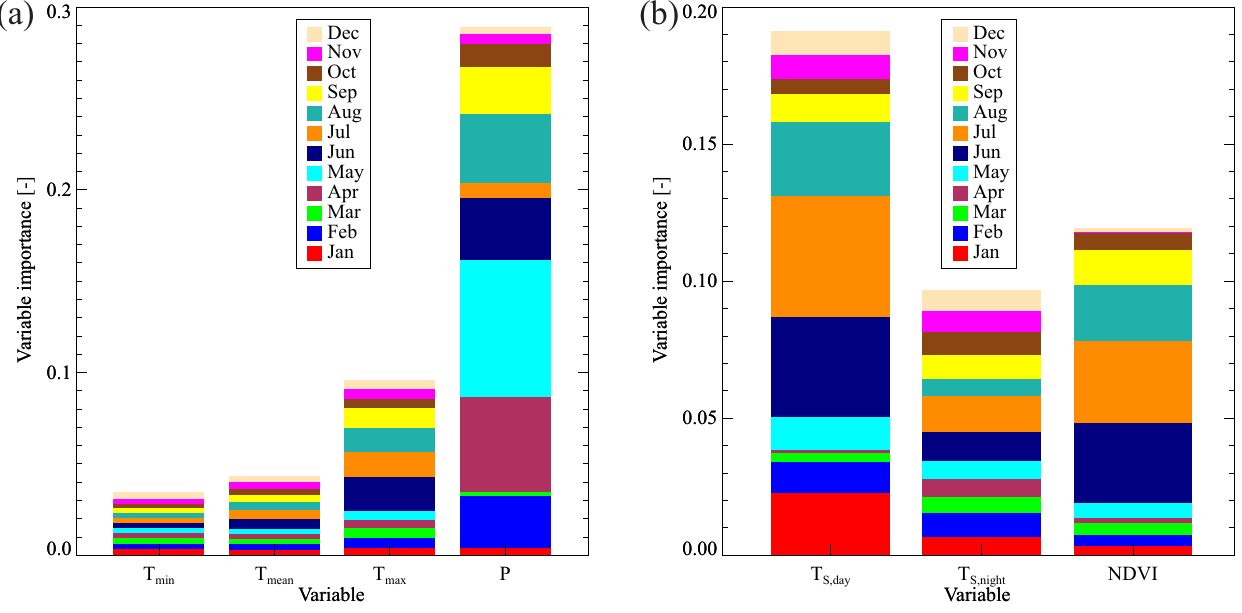
Relative importance of the different variables in the random forest models ( a ) based on climatic data and ( b ) based on standard Aqua MODIS